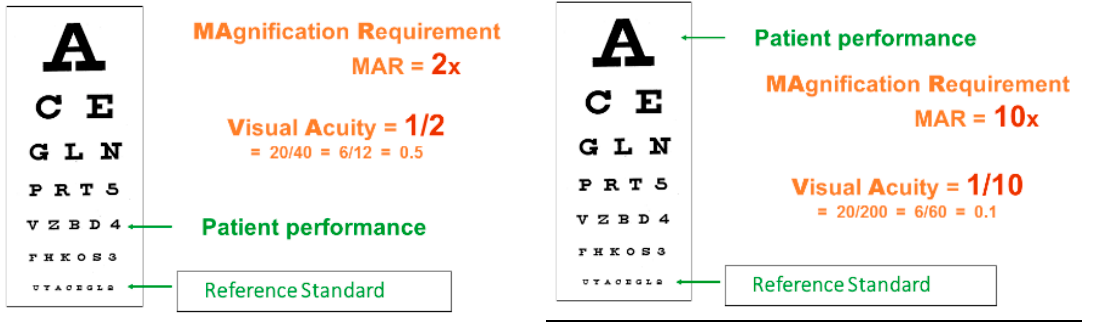
Figure A1. Visual acuity measurement.